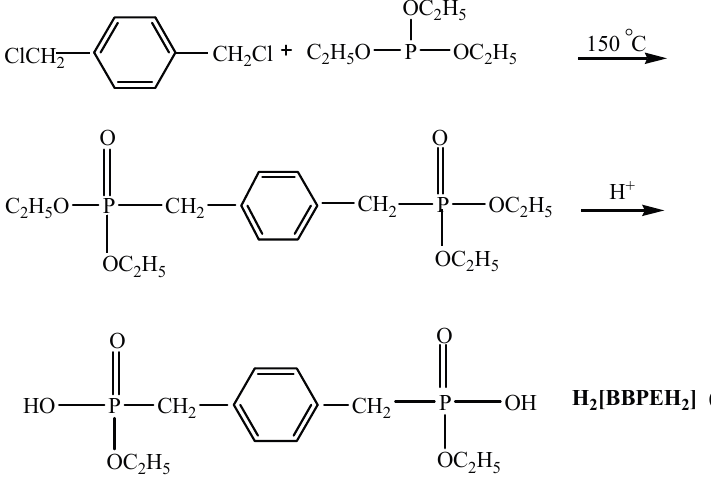
Scheme 1. Synthesis of compound 1